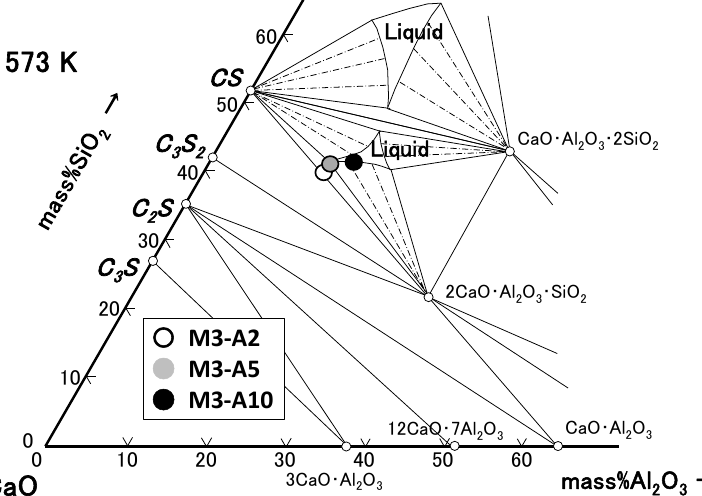
Figure 13. Composition of the observed phases in the quaternary samples containing Al 2 O 3 projected on a CaO-SiO 2 -Al 2 O 3 diagram.